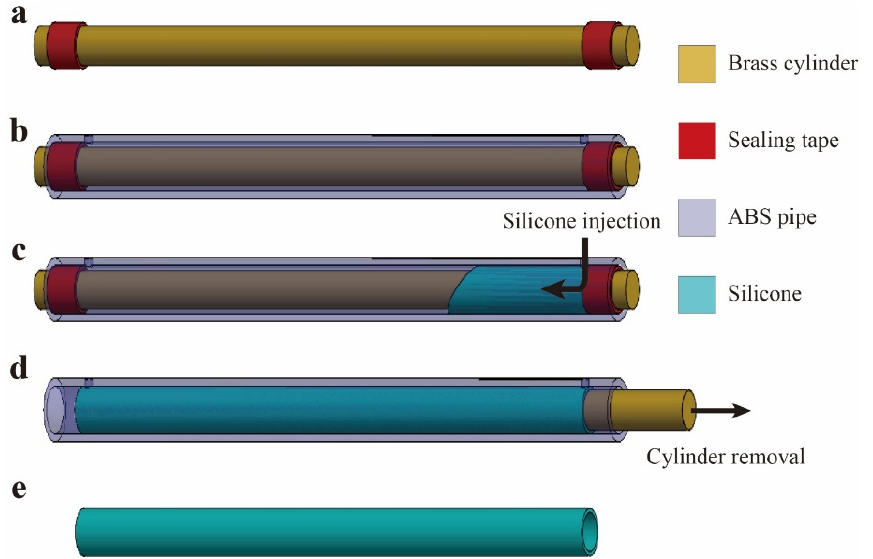
Figure 2. Fabrication process of silicone tube for DEFAs. ( a ) Inner mold made of a brass cylinder and sealing tape. ( b ) Outer mold made of ABS that contains the inner mold. ( c ) Injection of silicone mixture to the mold using a syringe, followed by curing in an oven. ( d ) Removal of the inner mold. ( e ) Silicone tube after taking off from the outer